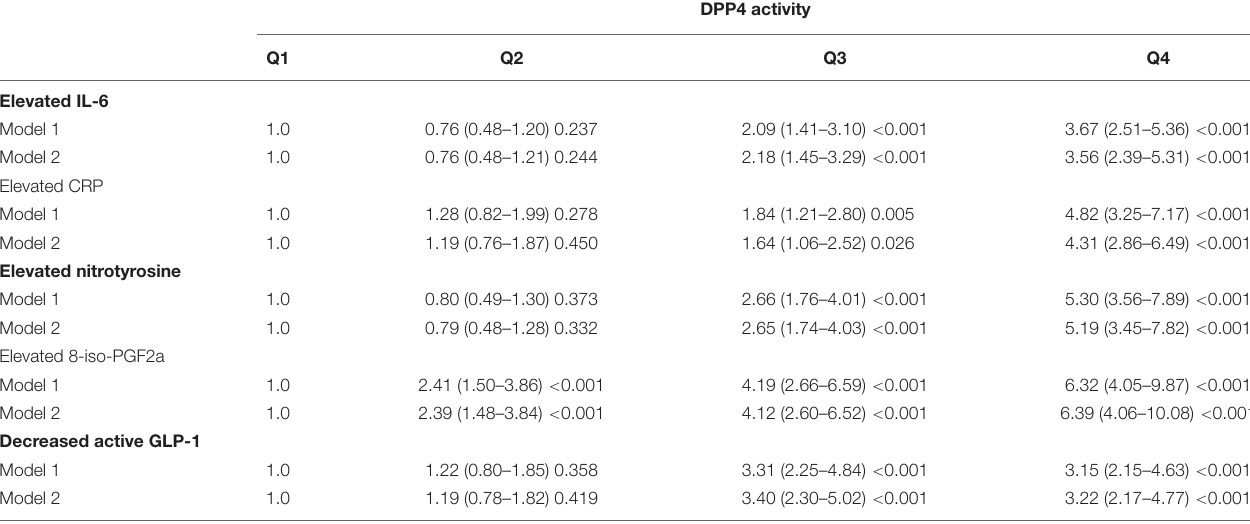
TABLE 4 | Adjusted ORs and 95% CIs for increased inflammation, oxidative stress, and decreased fasting active GLP-1 according to DPP4 quartiles.